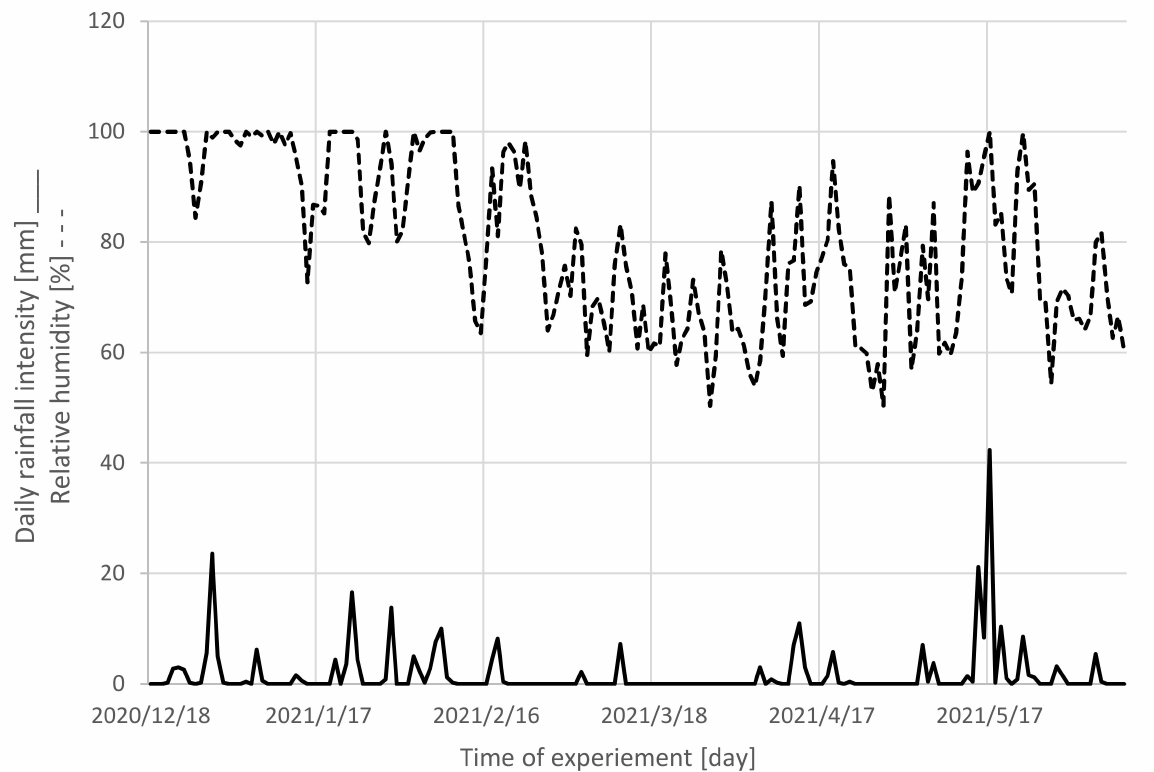
Figure 3. Daily rainfall intensity and relative air humidity during the 6-month-long